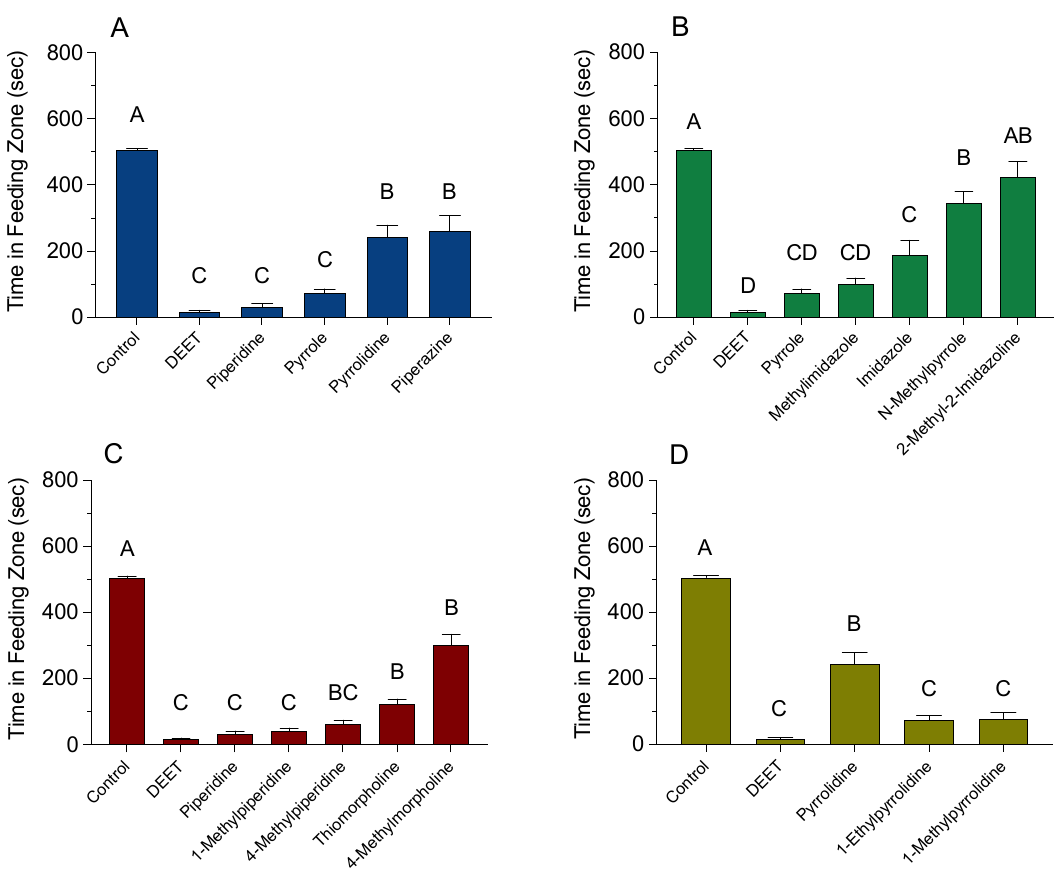
Figure 4. Effect of heterocyclic amines (HCAs) on the feeding behavior of honey bees. A video-tracking protocol to screen individual bees for behavior changes when exposed to sugar-agarose cubes treated with HCAs (10 µL/mL). Controls were sugar-agarose cubes with no treatment. DEET-treated sugar-agarose cubes were screened in each experimental cohort as a positive control. ( A ) HCA parent compounds (F (5, 488) = 173.70, P < 0.0001). ( B ) Substituted pyrroles (F (6, 523) = 123.10, P < 0.0001). ( C ) Substituted piperidines (F (6, 504) = 221.30, P < 0.0001). ( D ) Substituted pyrrolidines (F (4, 479) = 221.20, P < 0.0001). Vertical bars represent the mean ± standard error. Different letters above bars indicate significant differences using one-way ANOVA with Tukey’s post-hoc test ( P < 0.05).